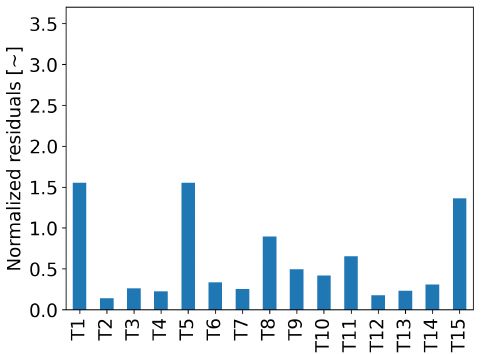
Figure 18. Iterative model: bar plots of MAE residuals (June 2021).